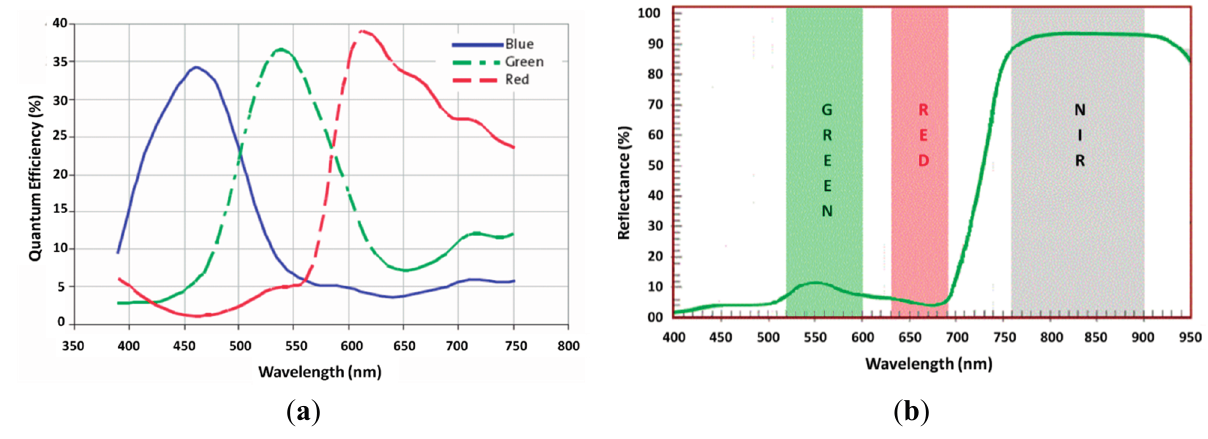
Figure 3. The response of the Aptina CMOS sensor to different bands through the R, G, and B filters ( a ). Tetracam ADC Micro bands with their spectral range and the spectral signature of vegetation ( b ).